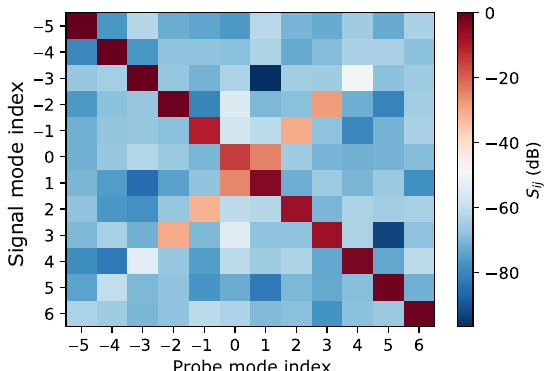
FIG. 14. Scattering matrix. Magnitude of scattering matrix elements measured with a single pump tone. Scattering occurs between modes symmetric in frequency around the pump. The mode indices are consistent with Fig. 4. The dB scale is refer- enced to the reflected amplitude in mode − 5.